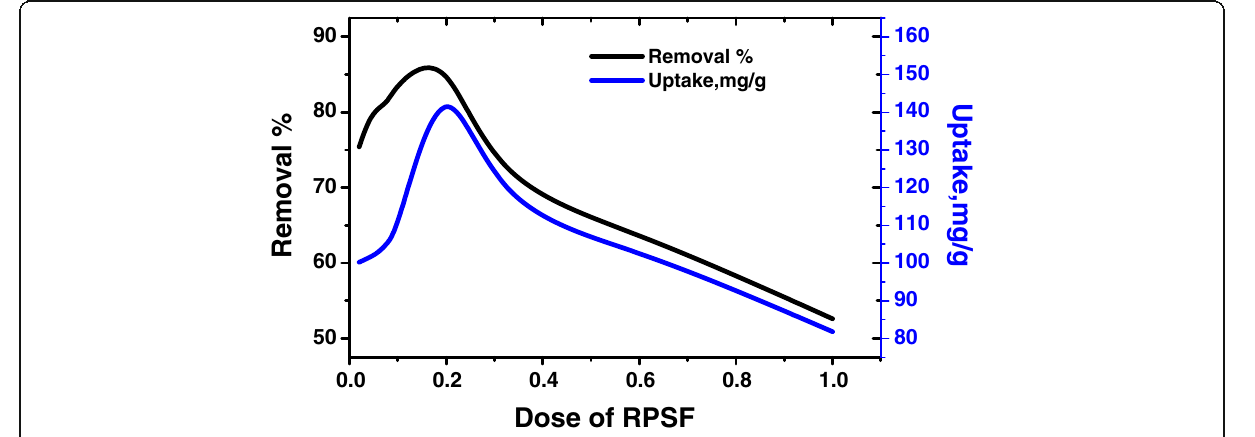
Fig. 6 Effect of adsorbent dosage of RPSF on adsorption of